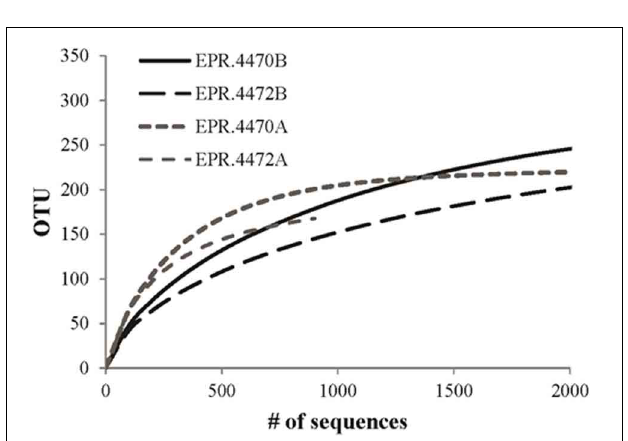
FIGURE 3 | Rarefaction analysis of archaeal (A) and bacterial (B) vent-specific 16S rDNA amplicon sequences from two 9 ◦ N East Pacific Rise (EPR) sites.